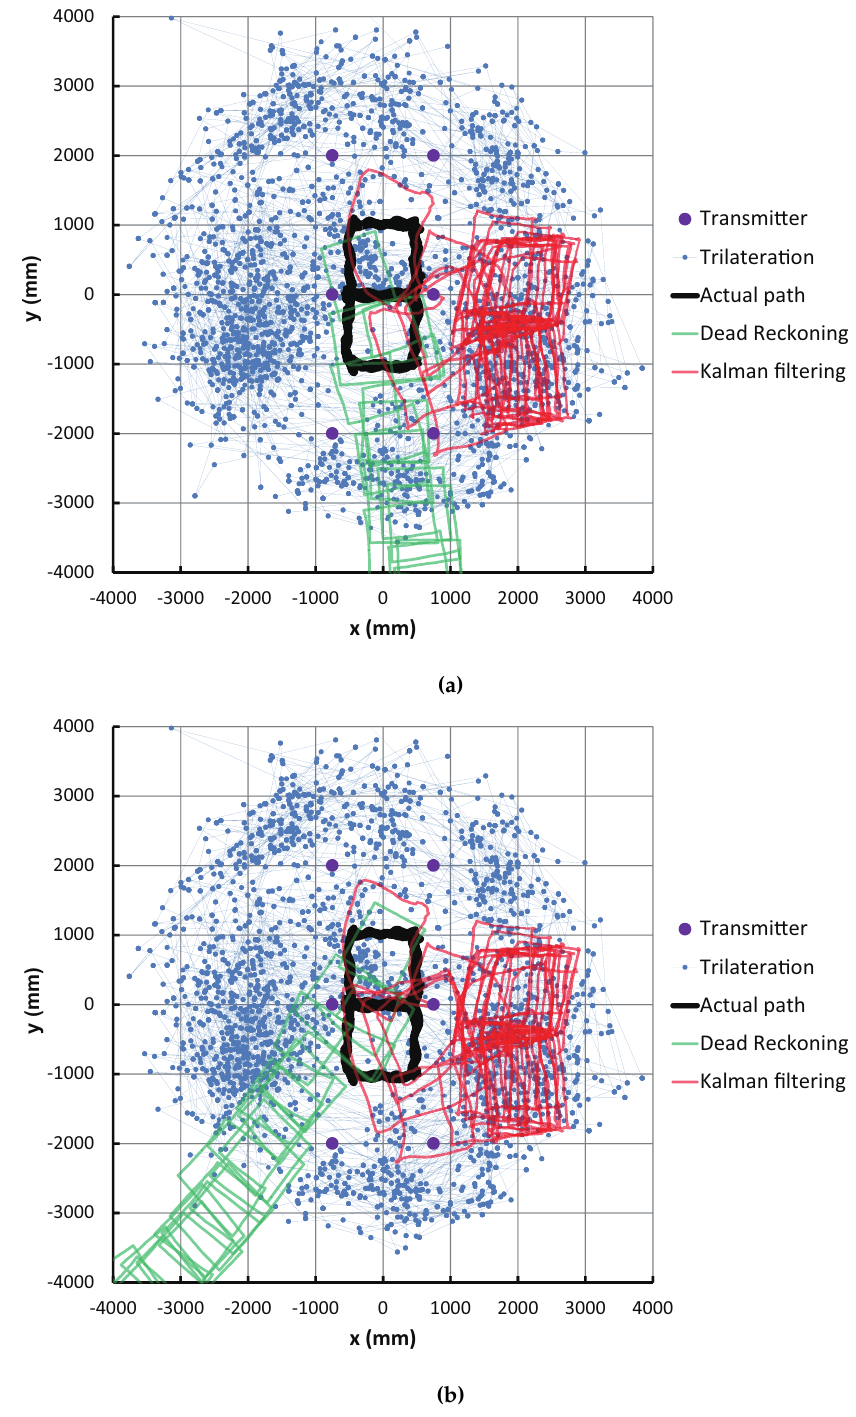
Figure 13. Experimental result of pedestrian position estimation. ( a ) Correct initial position and orientation; ( b ) Incorrect initial position and